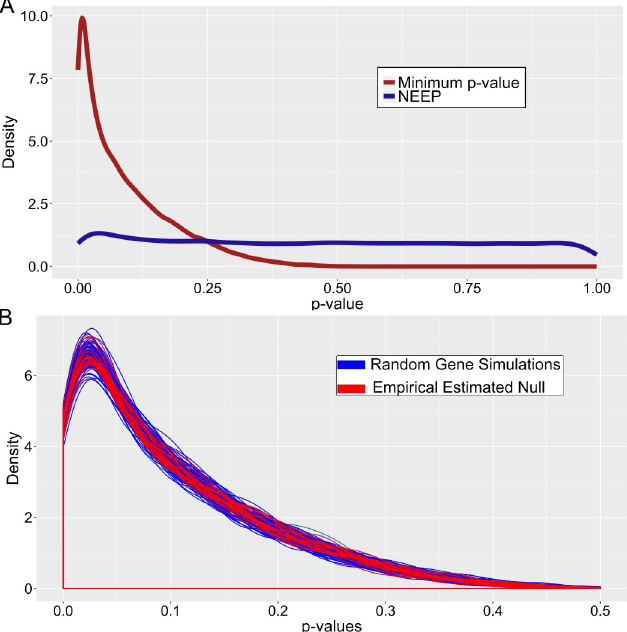
Fig 2. NEEP yields uniformly distributed p -values. (A) The p -value distribution is shown for the minimum p -value method and NEEP. An ideal statistical test produces p -values that are uniform under the null. (B) Density line plots were constructed for each of 100 simulations of 1000 random abundance patterns (blue) and 20 sets of 1000 values chosen at random from the initial 1,000,000 null distribution (red). The overlap between the two groups of density plots empirically confirms that the null distribution is the same for all expression patterns, given identical clinical